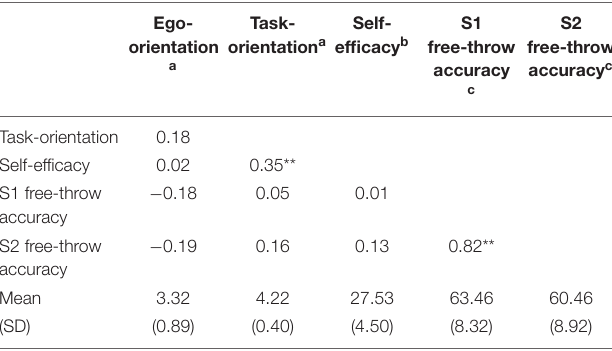
TABLE 1 | Means, standard deviations, and bivariate correlations for goal orientations, self-efficacy, S1 free-throw performance, and S2 free-throw